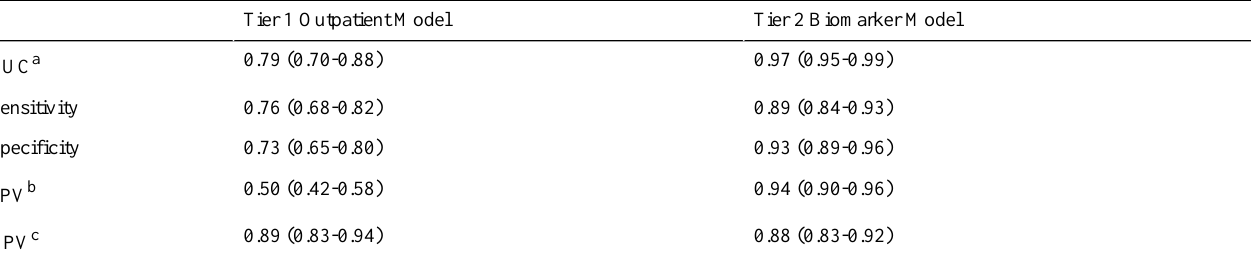
Table 3. External validation performance in terms of AUC, sensitivity, specificity, PPV, and NPV (95% CI). The Tier 1 Outpatient Model was evaluated on the Zhongnan Hospital dataset [26]. The Tier 2 model was evaluated on the Tongji Hospital dataset